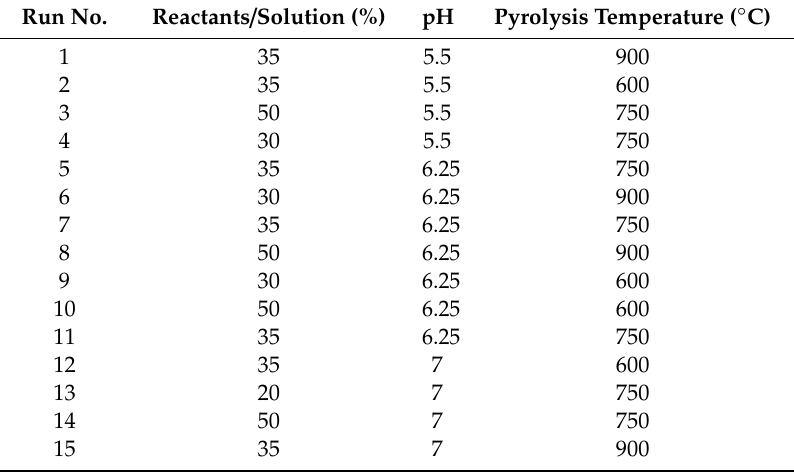
Table 1. Set of designed experiments according to BBD design. Run